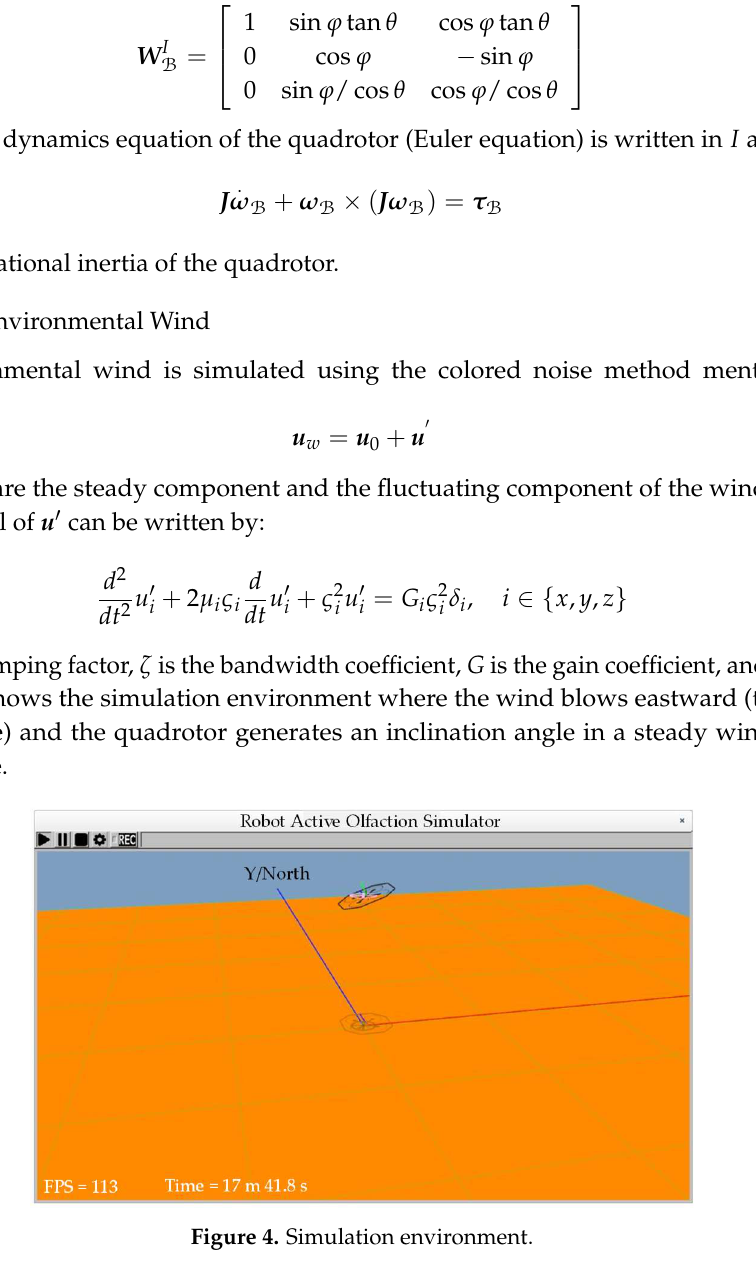
Table 1. Reference values for the parameters in the model of the quadrotor.